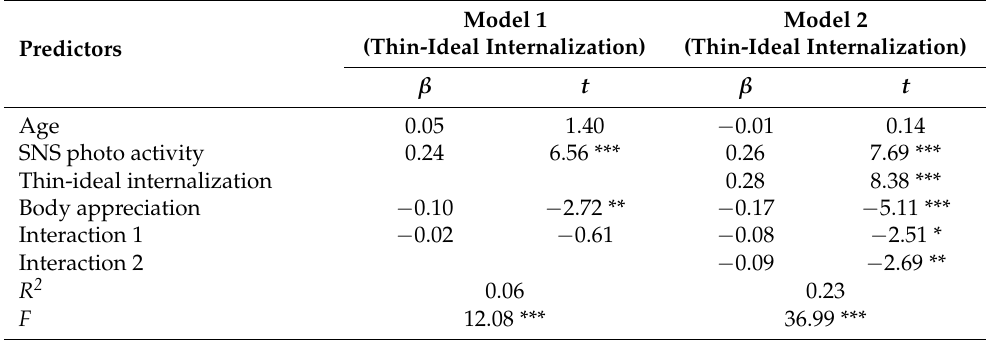
Table 3. Testing the moderated mediation effect of selfie-viewing on body dissatisfaction.